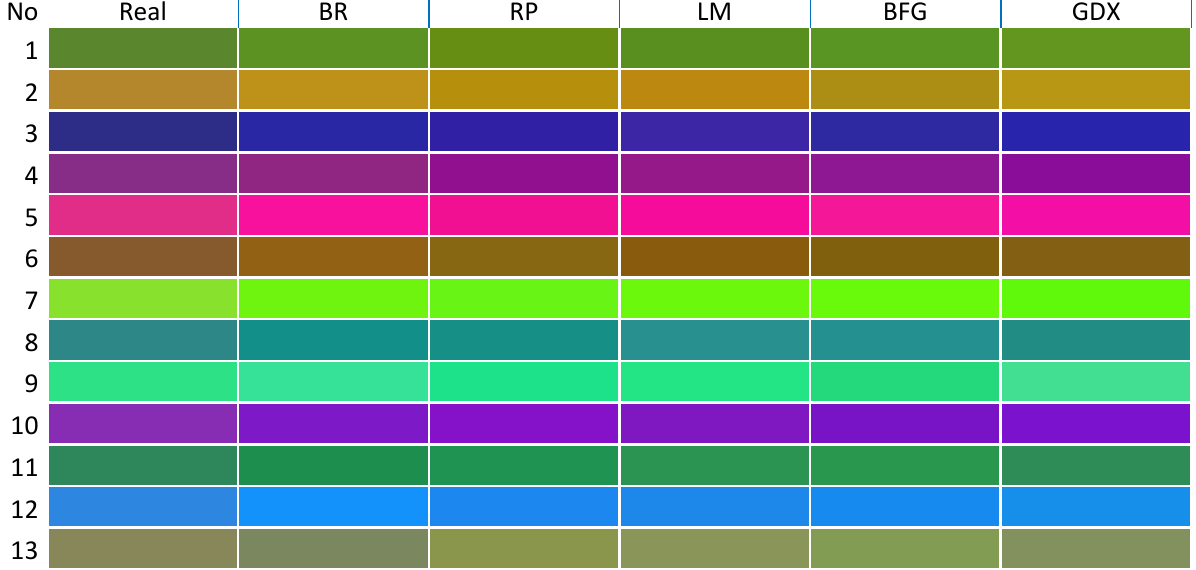
Table 5. Visual comparisons of the real RGB contents and proposed neural network